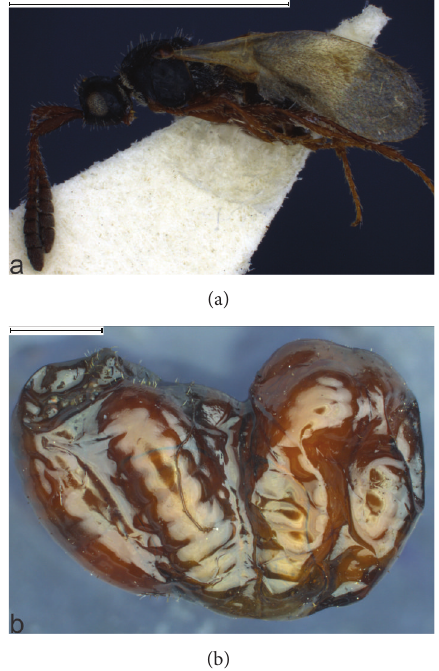
Figure 7: (a) Szelenyiopria pampeana female in lateral view. (b) Acromyrmex lobicornis larva showing immature instars of diapri- ines . Scale: 1